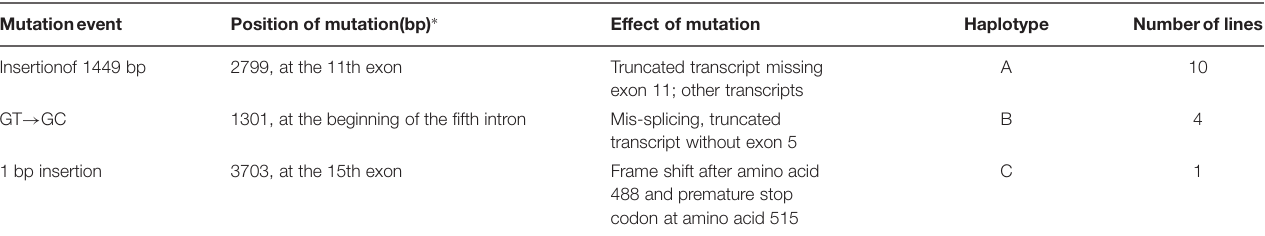
TABLE 1 | Molecular characterization of the three independent natural mutation types of the CsMLO1 alleles in resistant cucumber lines.